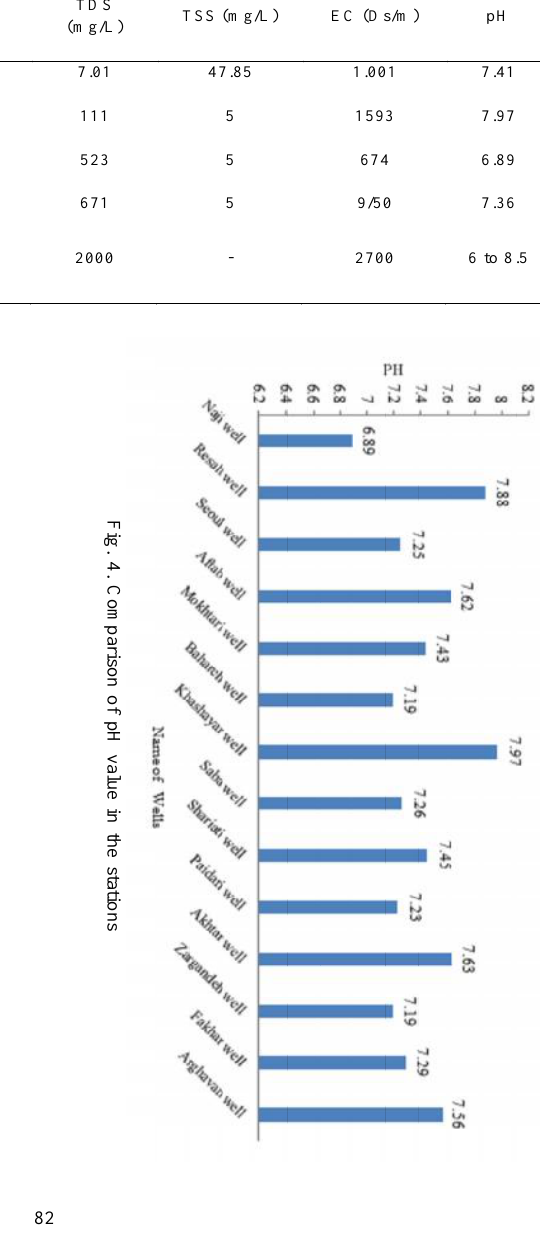
Table 3: The minimum and the maximum value of chemical parameters in the